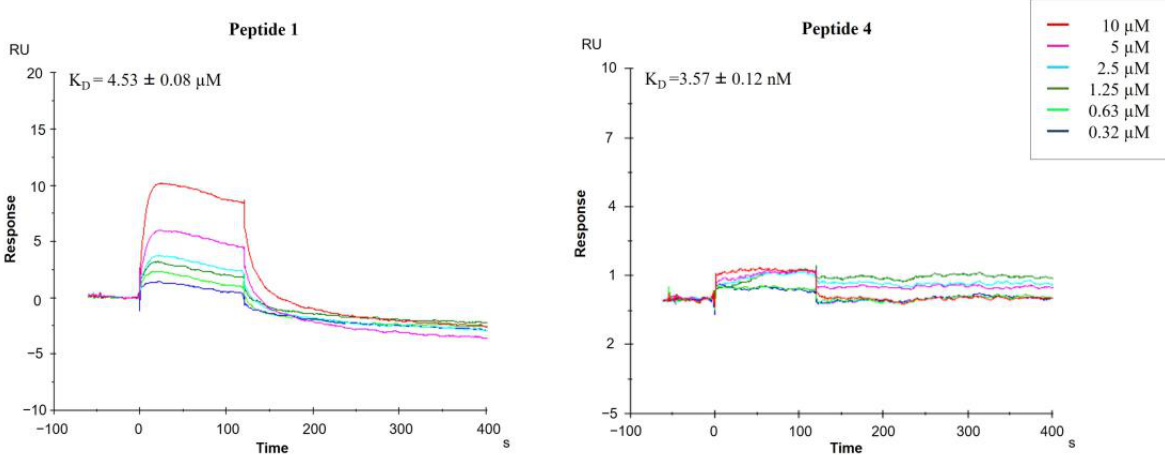
Figure 3. Sensorgrams obtained from the SPR interaction analysis of peptides 1 and 4 binding to immobilized HA (H1N1 hemagglutinin, Cat No: Z03181, GenScript, NE). Each compound was injected at six different concentrations (0.32, 0.63, 1.25, 2.5, 5 and 10 µ M). The equilibrium dissociation constants (K D ) were derived from the ratio between kinetic dissociation (k off ) and association (k on ) constants.